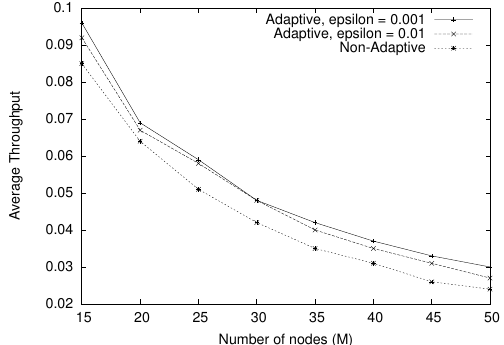
Figure 3: Av. throughput (heterogeneous case).